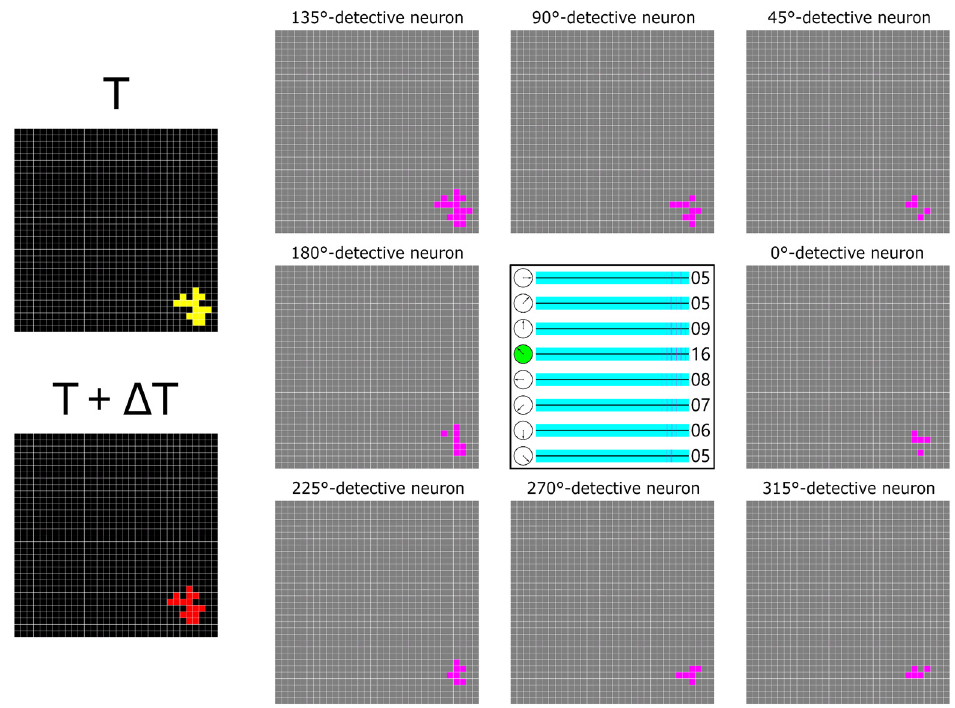
Figure 5. The activation plots of the AVS for 16-pixel object motion direction detection within the background with no noise.